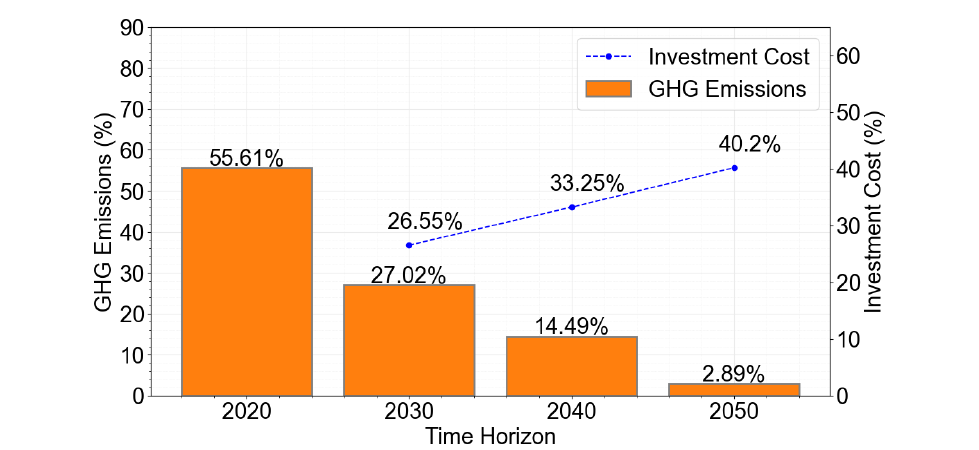
Figure 11. Alternative 2—Comparison between emissions and the investment cost for the Service